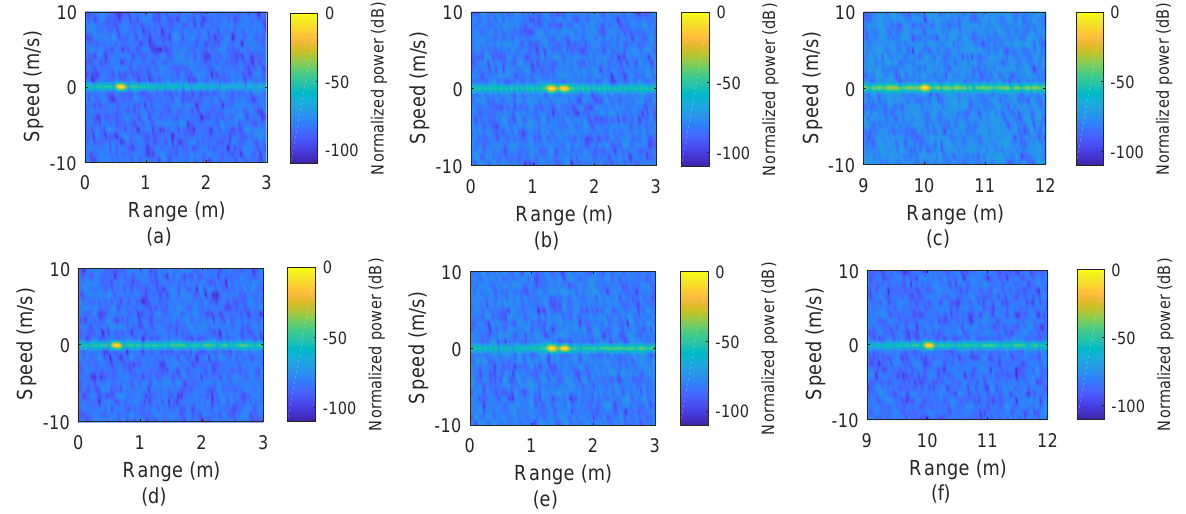
Figure 4. Simulation results of the conventional OFDM–based sensing vs. the proposed range extension method. ( a – c ) Range plots for a target at 0.6 m, two targets at 1.3 m and 1.5 m, and a target at 10 m, respectively, by using conventional OFDM–based sensing. ( d – f ) Range plots obtained by using the proposed range extension